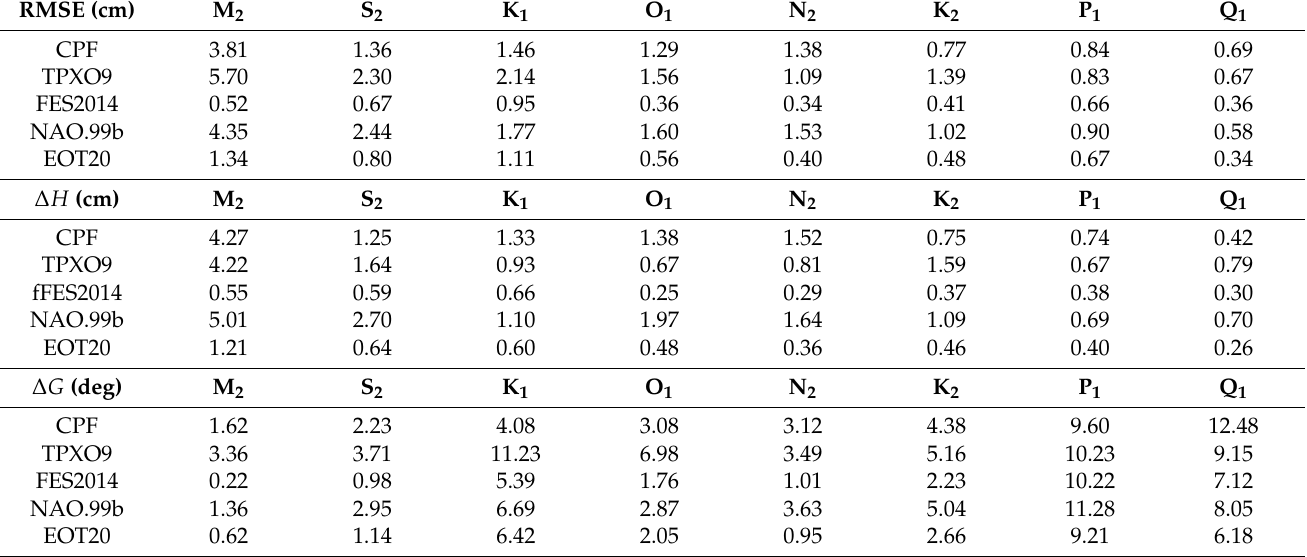
Table 2. The RMSEs and MAEs of the harmonic constants of the results calculated by the CPF method, the TPXO9, FES2014, NAO.99b and the EOT20 models for the eight major constituents, compared with the X-TRACK coastal satellite